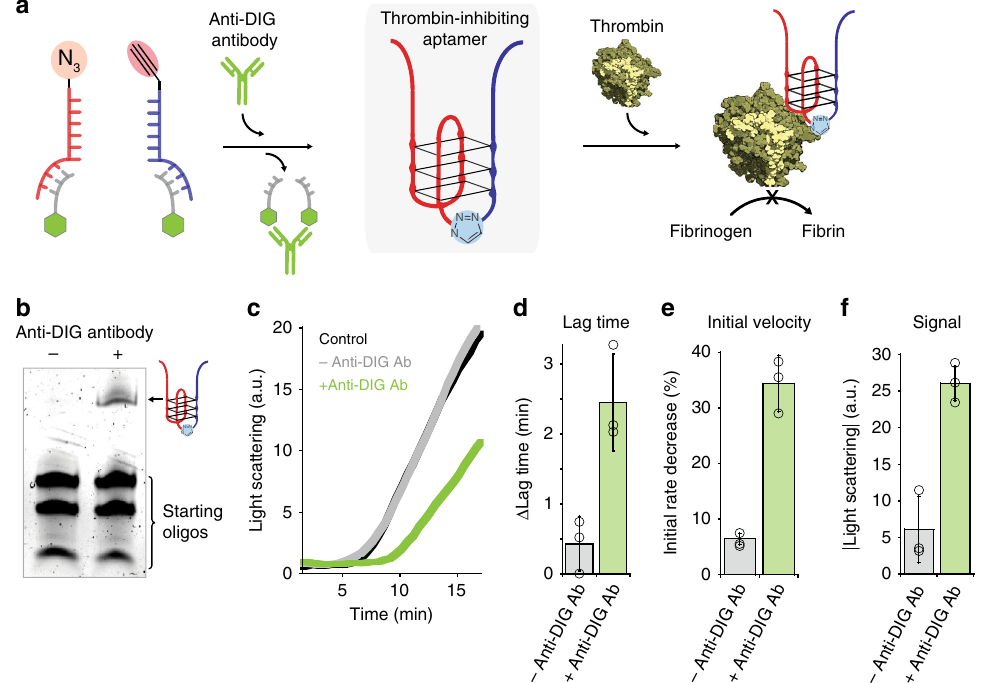
Fig. 5 Templated synthesis of thrombin-inhibiting aptamer mediated by anti-DIG antibody. a Scheme of the produced thrombin-inhibiting aptamer by a templated click reaction mediated by anti-DIG antibody. b Denaturing PAGE of CuAAC reactions in the absence and presence of anti-DIG antibody. c Light scattering measurements of thrombin activity ( fi brin formation). Thrombin was incubated with the resulting reaction products obtained from the CuAAC reaction between the antigen-conjugated templating strands in the absence (gray curve) and presence (green curve) of anti-DIG antibody. A control experiment with thrombin alone is also shown as a reference (black curve). d Lag time of thrombin activity. Plotted is the difference in the lag time (time required before substrate conversion starts, observed from light scattering measurements) with respect to that of thrombin alone. e Reduction of the initial velocity (%) with respect to that of thrombin alone. f Maximum light scattering signal observed after 30 min with respect to that of thrombin alone. Templated CuAAC reactions in this fi gure were all performed at 37 °C for 2 h at a 100 nM concentration of templating strands and 300 nM of anti-DIG antibody in presence of Cu(l) catalyst in 25 mM HEPES buffer pH 7.2, 0.1 M NaCl. Light scattering measurements were accomplished with a 10 mg/ml concentration of fi brinogen, 0.5 nM thrombin, and 125 nM of reaction products in 1% saline solution pH 7 at 25 °C. The experimental values represent averages of three separate measurements and the error bars re fl ect the standard deviations. Source data are provided as a Source Data fi